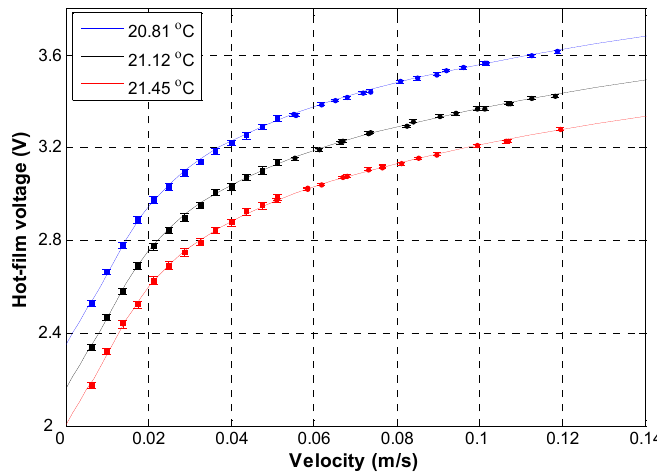
Figure 2. Hot-film calibration at three temperatures.